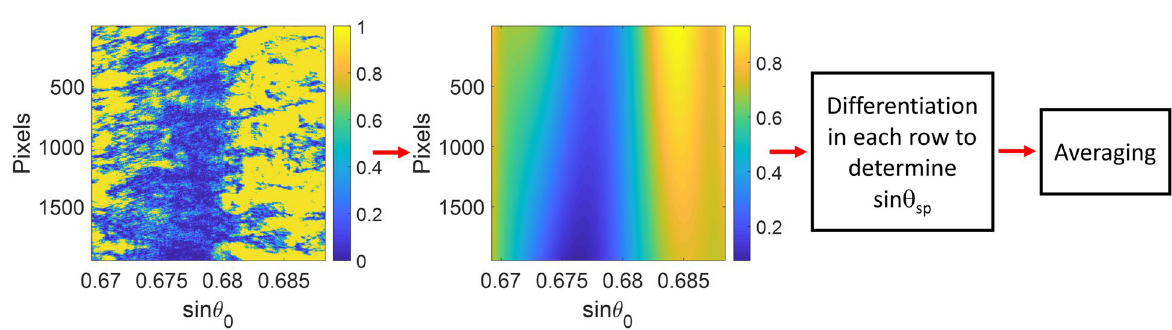
Figure 3. Steps in Horner’s curve fitting for SPR dip